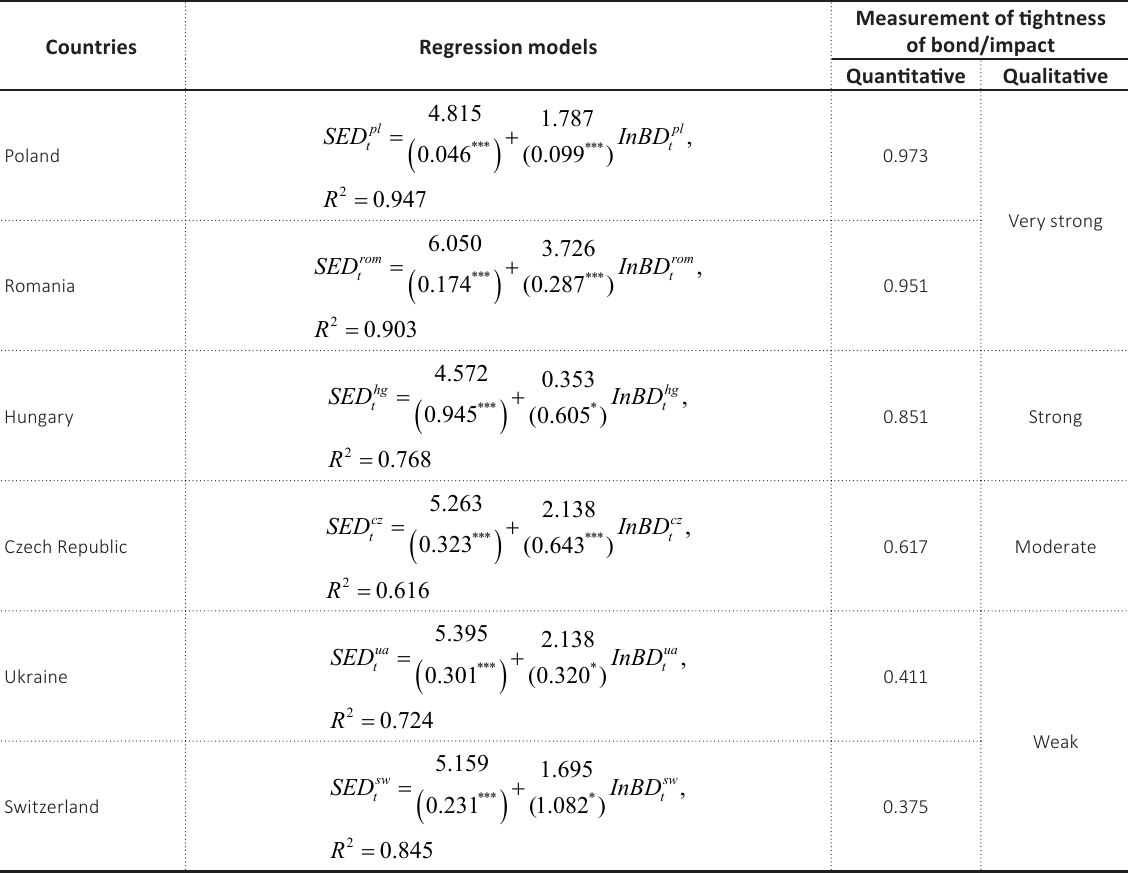
Table 6. Empirical assessments of the impact of the banking sector on the social and economic development of some EU countries, Switzerland, and Ukraine Source: Authors’ own calculations using EViews 11